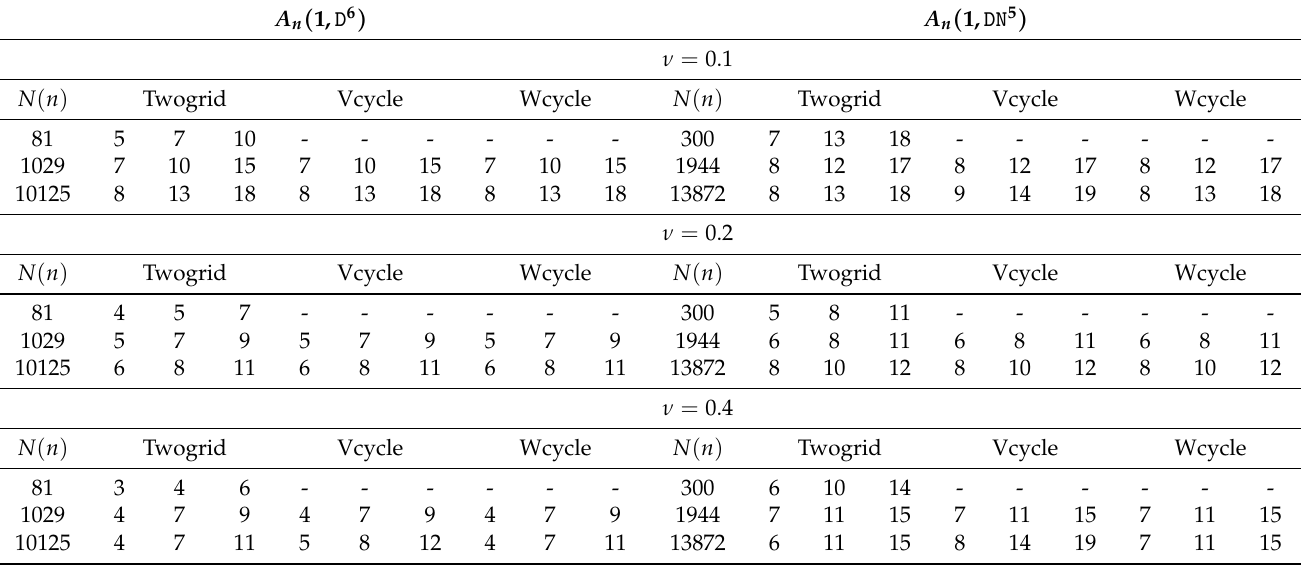
Table 1. Number of iteration for matrices A n ( 1, D 6 ) and A n ( 1, DN 5 ) of increasing dimension N ( n ) , with the numeric precision ε = 10 − 4 ,10 − 6 ,10 − 8 ,